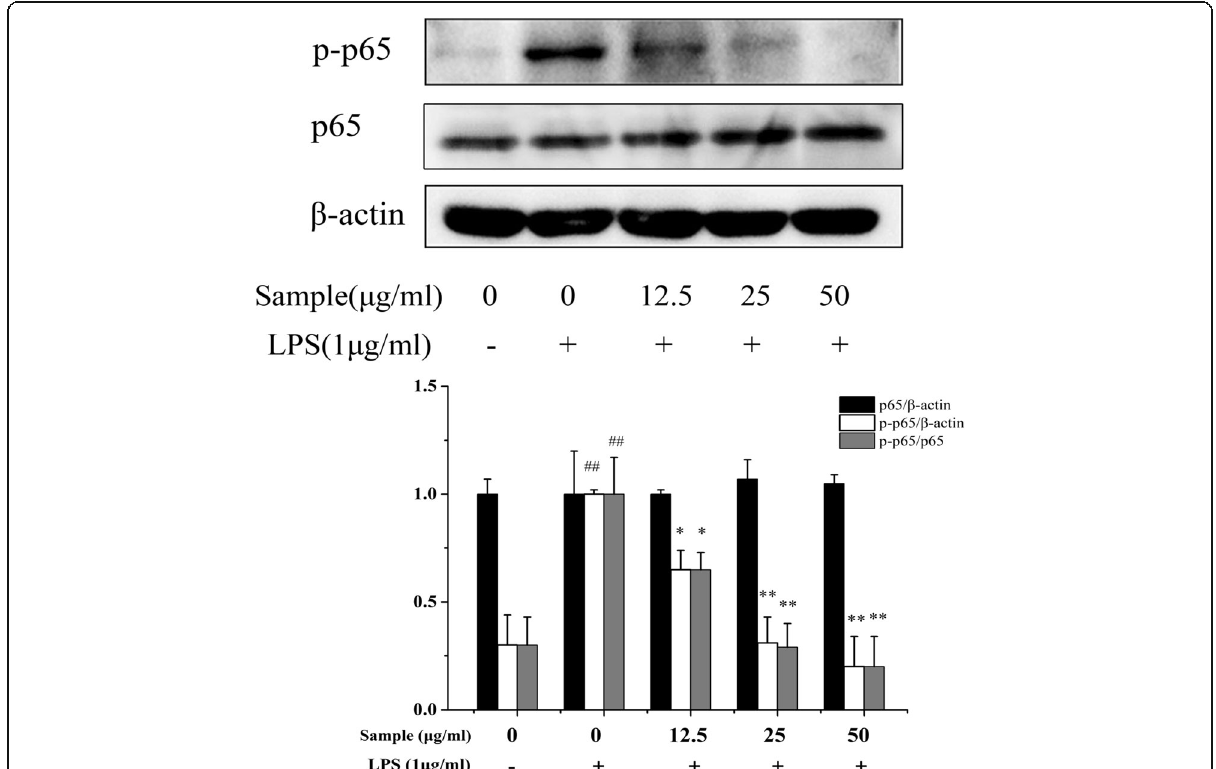
Fig. 6 Effect of YYHs on LPS-induced activation of NF- κ B pathway in RAW 264.7 cells. The cells were pretreated with different concentrations of YYHs for 2 h and then stimulated with LPS(1 μ g/mL) for another 1 h. The NF- κ B p65 and phosphorylated p65 in the total protein was detected by western blotting. β – acting was used as the internal control for normalization. Compared with the control, # P < 0.05, ## P < 0.01. Compared with LPS group, * P < 0.05, ** P <